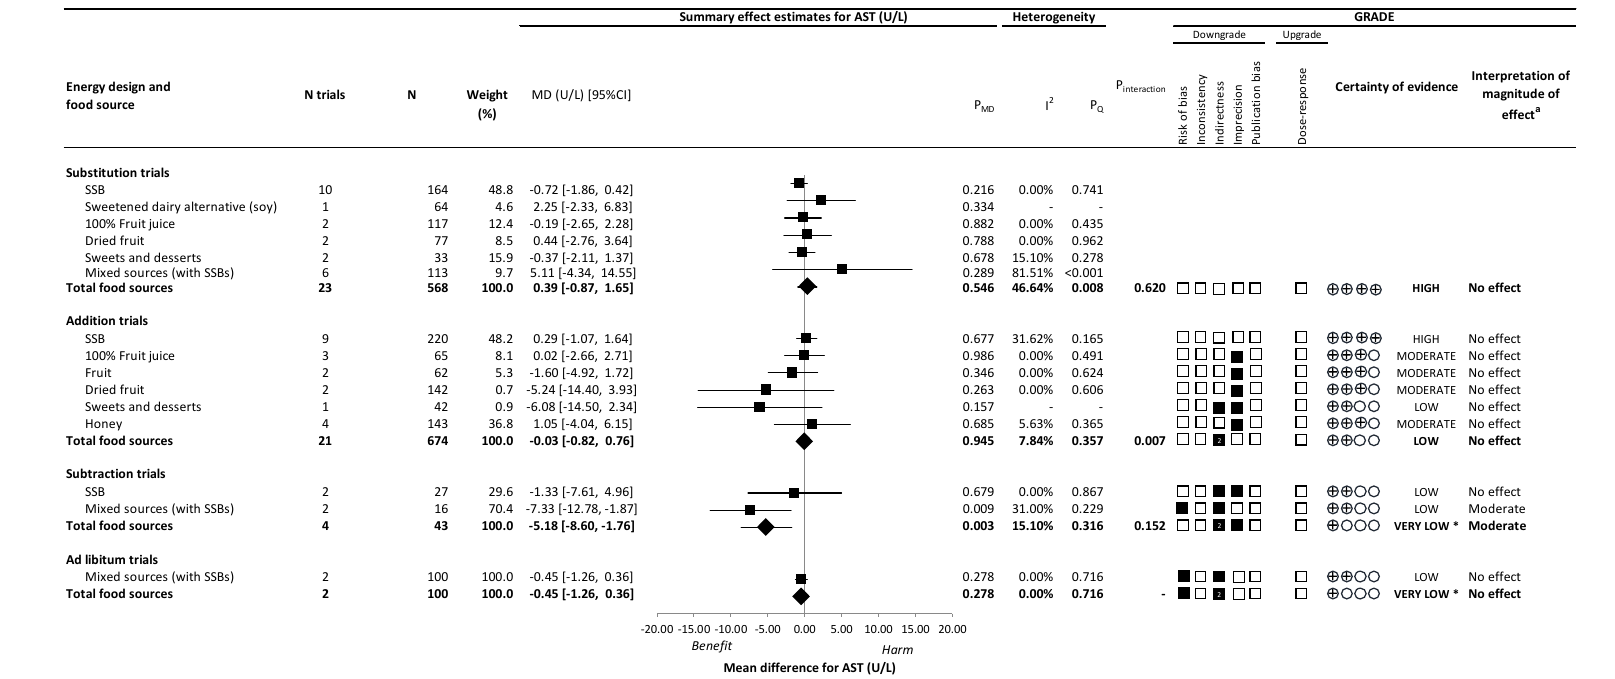
Figure 4. Summary plot for the effect of important food sources of fructose-containing sugars on aspartate aminotransferase (AST). Data are weighted mean differences (95% confidence intervals) for summary effects of individual food sources and total food sources on ALT. Analyses conducted by generic, inverse variance random effects models (at least five trials available) or fixed effects models (fewer than five trials available). Between-study heterogeneity was assessed by the Cochrane Q statistic, where P Q < 0.100 is considered statistically significant, and quantified by the I 2 statistic, where I 2 ≥ 50% is considered evidence of substantial heterogeneity. The Grading of Recommendations, Assessment, Development and Evaluation (GRADE) of randomized controlled trials are rated as “High” certainty of evidence and can be downgraded by five domains and upgraded by one domain. The white squares represent no downgrades, while filled black squares indicate a single downgrade or upgrades for each outcome, and the black square with a white “2” indicates a double downgrade for each outcome. AST = aspartate aminotransferase; CI = confidence interval; GRADE = Grading of Recommendations, Assessment, Development and Evaluation; MD = mean difference; N = number; SMD = standardized mean difference; SSB = sugar-sweetened beverage. a For the interpretation of the magnitude, we used the MIDs to assess the importance of magnitude of our point estimate using the effect size categories according to new GRADE guidance. * Where there was a significant interaction by food source in substitution and addition trials and SSBs and mixed sources were the sole food sources in subtraction and ad libitum trials, we performed the GRADE analysis for each individual food source. To convert U/L to ukat/L, multiply U/L by 0.0167.